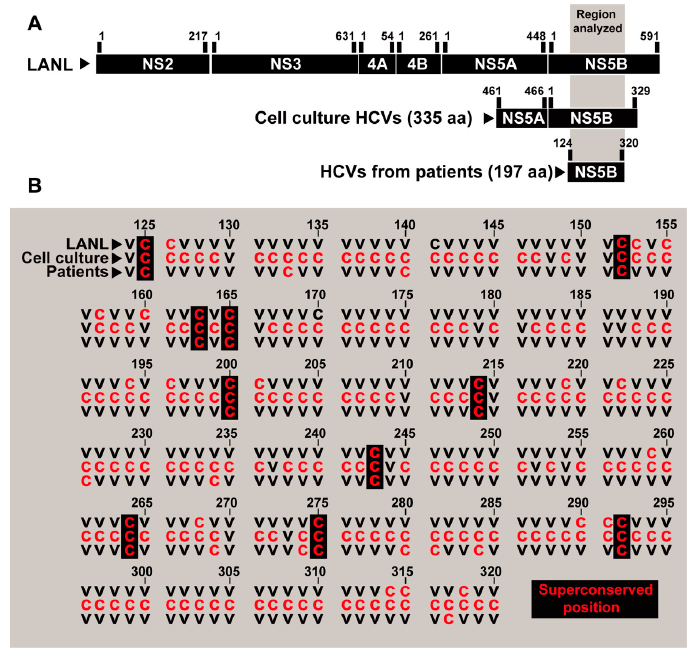
Figure 7. Distribution of superconserved positions among the amino acids 124 to 320 of NS5B (corresponding to genomic residues 7971 to 8561; numbering according to HCV reference isolate H77). ( A ) Scheme of the different regions and the number of amino acids analyzed from patients, cell culture or LANL. ( B ) Sequence alignment to indicate conserved positions. All amino acid substitutions identified in quasispecies of HCV evolving in cell culture and in infected patients, analyzed in the present study, were considered to determine that a site is variable. Totally conserved positions are depicted by a red C, and variable positions (independently of the origin and extent of the variation) by a black V. Superconserved positions are indicated by a black rectangle.